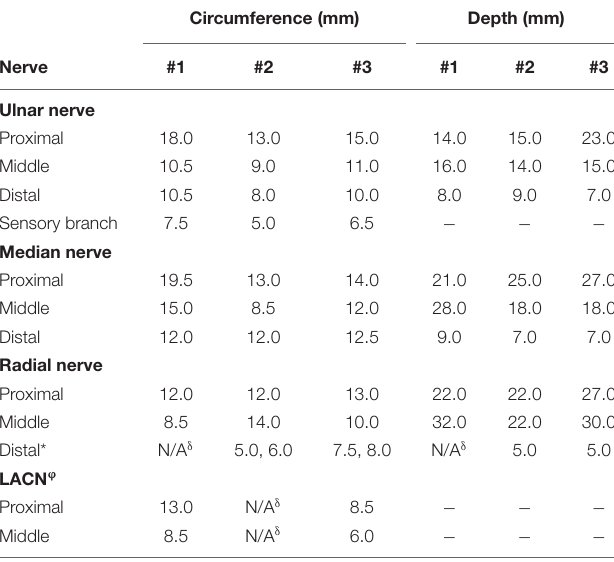
TABLE 1 | Upper extremity nerve